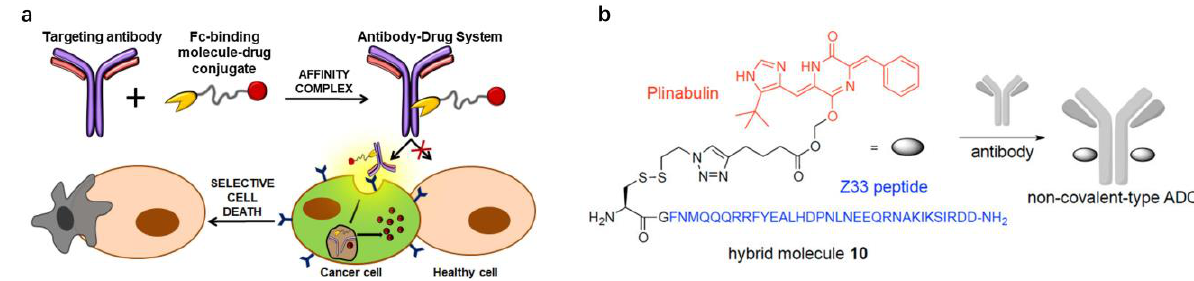
Figure 4. Examples for the construction of non-covalent antibody–drug conjugate based on affinity motif. ( a ) Schematic illustration of the non-covalent ADC systems composed of an anti-tumor agent (Tubulysin A) and IgG affinity protein pG. Reproduced with permission from Ref [67]. Copyright 2019 Eur J Pharm Biopharm. ( b ) Schematic illustration of the novel probe for non-covalent-type ADC composed of an anti-tumor agent (plinabulin) and IgG affinity peptide Z33. Reproduced with permission from Ref [14]. Copyright 2016 Bioconjugate Chem .